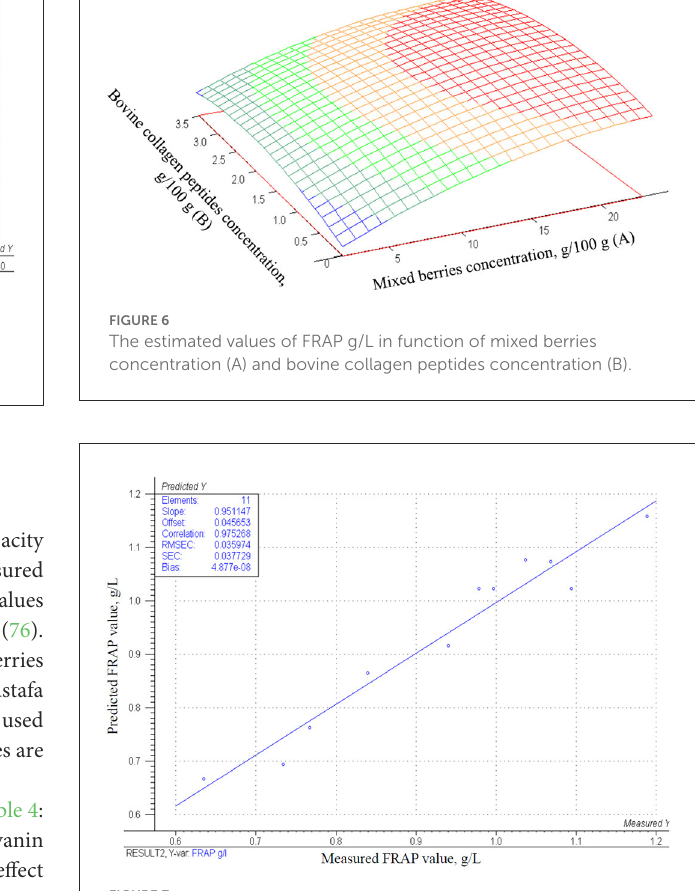
correlation between mixed berries concentration and TPC might be assumed from measured values. This finding is supported by the results of the estimated CCRD model ( p = 0.0001) described in Table 4. Regarding the regression coefficients and p -values, the mixed berries concentration has a significant effect ( p = 0.0002) on TPC and the correlation of both factors are positive ( β -coefficient = 4.97E- 02; β -coefficient = 2.93E-03, respectively) as well as their interaction correlates positively ( β -coefficient = 5.78E-03), although factor B and the interaction of both factors are not significant ( p = 0.924 and p = 0.895, respectively). This is shown in Figure 8. The estimated values and measured values are demonstrated in Figure 9 ( r 2 =